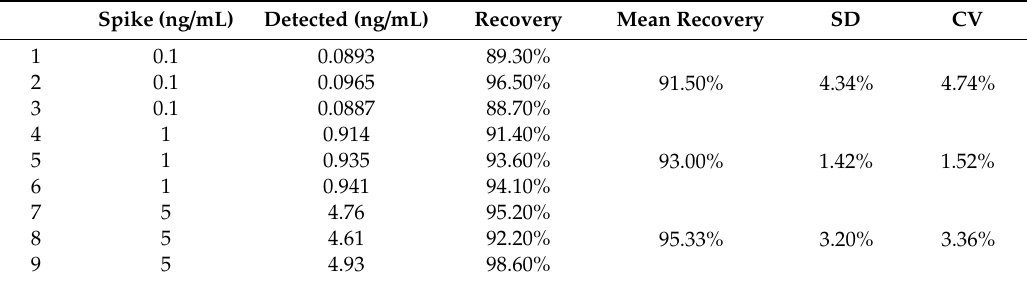
Table 2. Results of recovery evaluation.